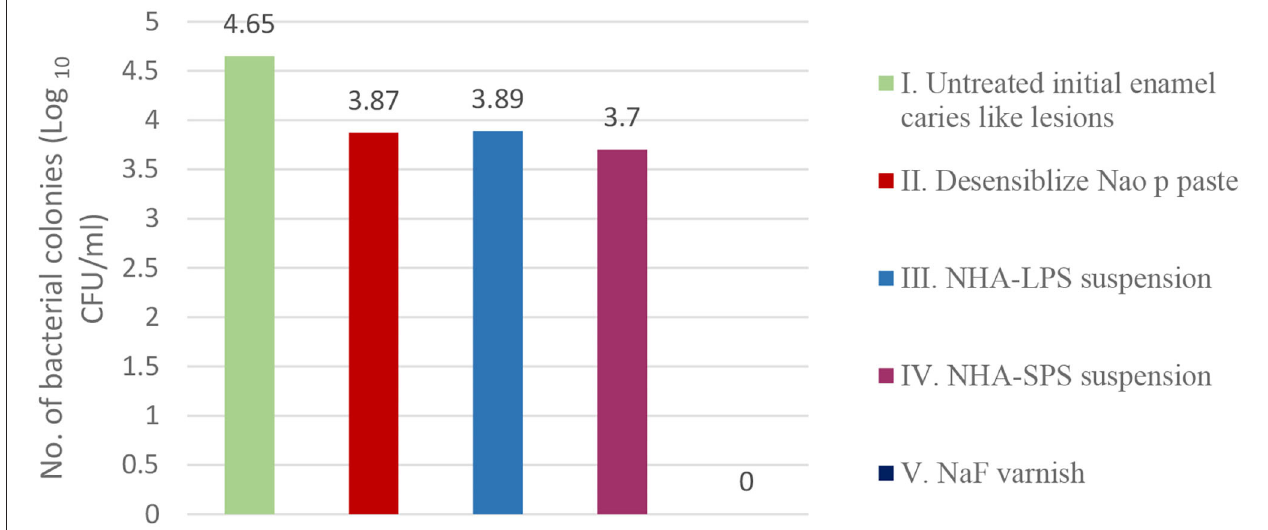
TABLE 6 | Mean values of bacterial biofilm thickness ( µ m) in all tested groups and statistical analysis. Groups Mean ± S.D ANOVA test